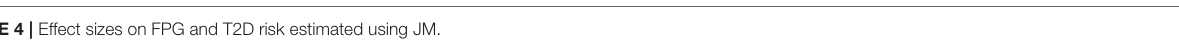
TABLE 4 | Effect sizes on FPG and T2D risk estimated using JM.